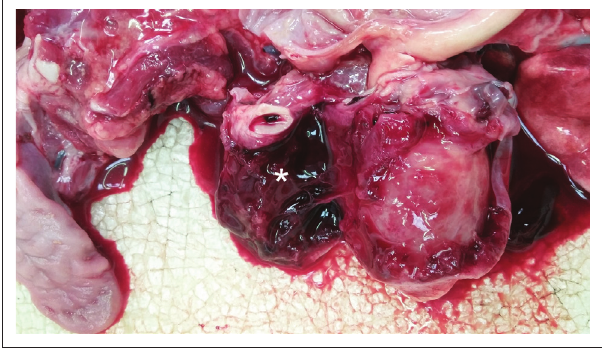
FIGURE 4: Post mortem photograph. The pericardial sac is transected and reflected to expose the epicardium. Note the severe fibrous changes associated with the epicardial surfaces and pericardial sac consistent with a constrictive